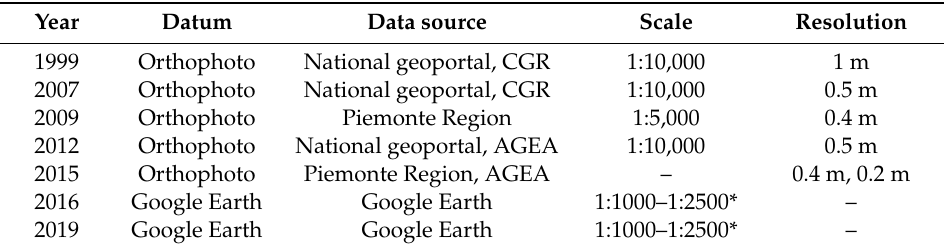
Table 1. List of cartographic data used in this research. The scale values marked with * indicate the scale range of data visualization. CGR: Compagnia Generale Riprese Aeree; AGEA: Agenzia per le Erogazioni in